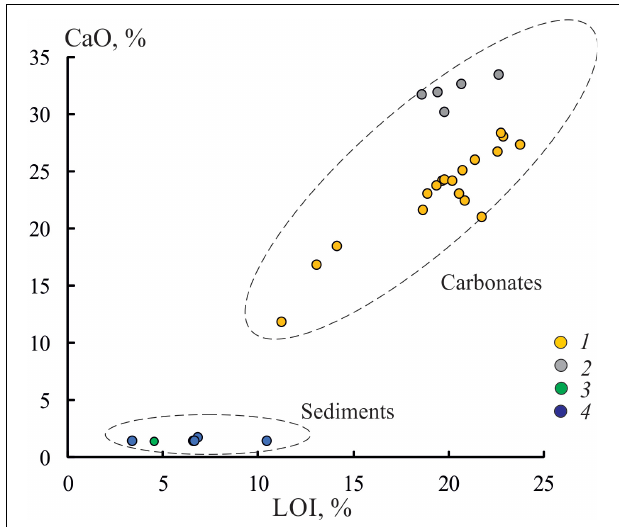
FIGURE 7 | Relationship between LOI and CaO in carbonate crusts and sediments: 1 , sample OD-I-1; 2, samples OD-I-2 and OD-I-3; 3 , bottom sediment sample from cavities of the carbonate crust OD-I-3; 4 , surface bottom sediments.